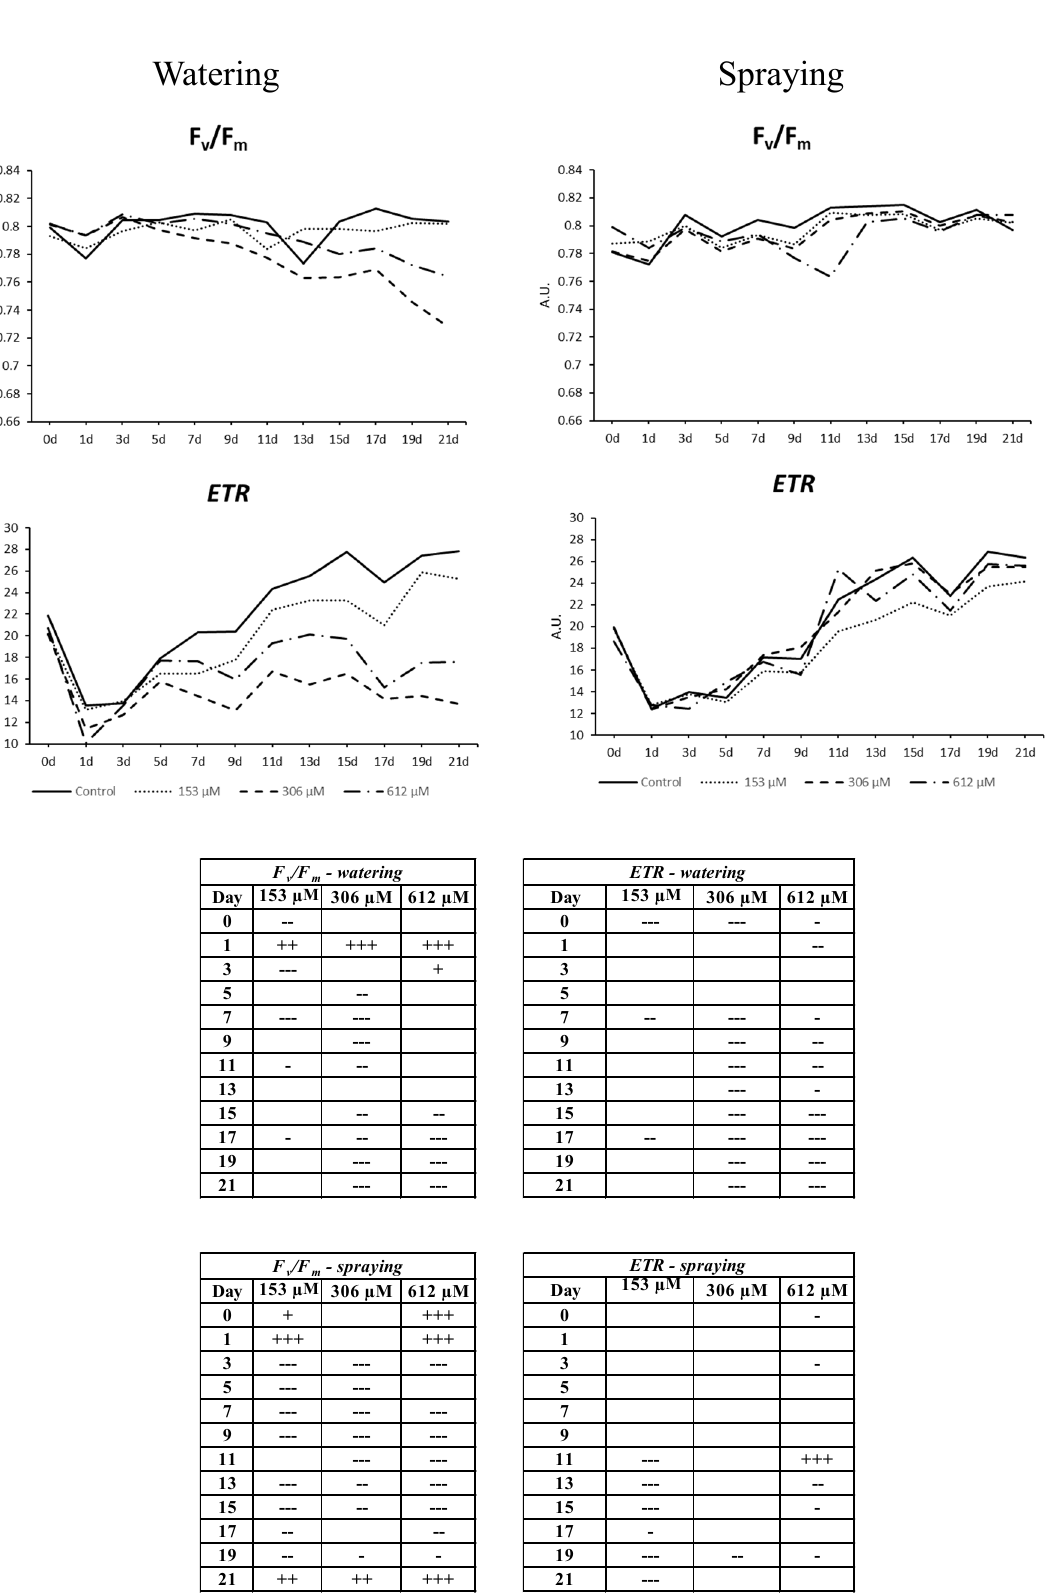
Figure 9. Mean values, expressed in arbitrary units (AU), of F v /F m and electron transport rate (ETR) in A. thaliana adult plants watered or sprayed for 21 days with different concentrations of norharmane (0, 153, 306 and 612 µM). Tables show the statistical significance compared to the control on each day and treatment (+, stimulatory difference; -, inhibitory difference; + or -, p ≤ 0.05, ++ or --, p ≤ 0.01, +++ or --- p ≤ 0.001).